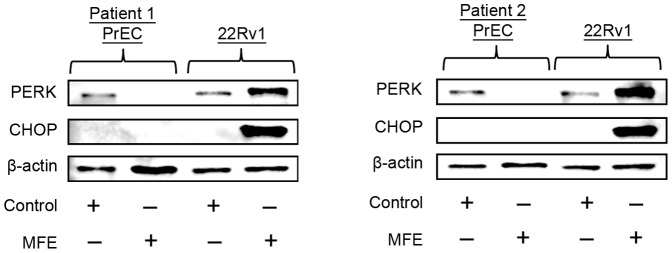
The effects of MFE on Prostate epithelial cells (PrECs) from prostate cancer patients.PrECs were isolated from patients undergoing radical prostatectomy. Samples were then used to prepare cells for treatment with study agents. PrECs from two different prostate cancer patients or 22Rv1 cells were treated with 15 µg/ml of MFE for 24 hr and then subjected to Western blots. Beta-actin was used as a loading control. Minus and plus symbols respectively represent absence and presence of indicated agents. These results are representatives from three independent experiments.